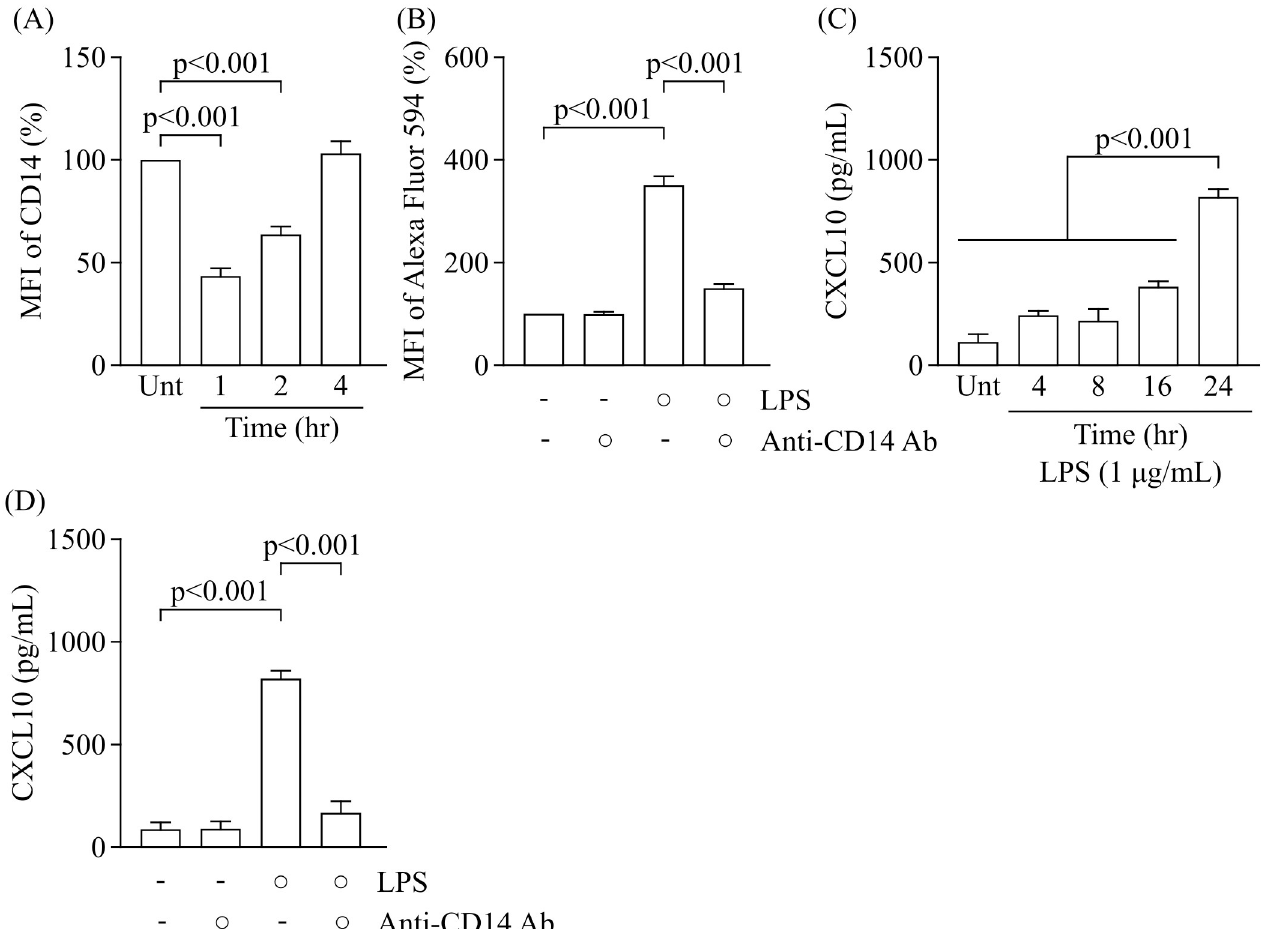
Fig 2. Involvement of CD14 on LPS uptake and CXCL10 release in response to LPS. (A) Time course of MFI related to CD14 in RAW264.7 cells treated with LPS at 1 μ g/mL (n = 3, Dunnett’s test). (B) Effect of anti-CD14 antibody at 20 μ g/mL on LPS uptake (n = 3, Tukey’s test). Neutralising antibody was added 1 h before treatment with Alexa Fluor 594-labelled LPS at 1 μ g/mL and incubated for 4 h. MFI relative to the untreated group (medium alone) was arbitrarily defined as 100%. (C) Time course of CXCL10 levels in the culture supernatants obtained from cells treated with LPS at 1 μ g/mL (n = 6, Dunnett’s test). (D) Effect of anti-CD14 antibody at 20 μ g/mL on CXCL10 release from RAW264.7 cells treated with LPS at 1 μ g/mL (n = 3, Tukey’s test). CXCL10 levels in the culture supernatants obtained from cells treated with LPS and/or anti-CD14 antibody for 24 h were measured by ELISA. Data are presented as the means ± SEM. MFI; mean fluorescence intensity. Unt; untreated. Ab; antibody.